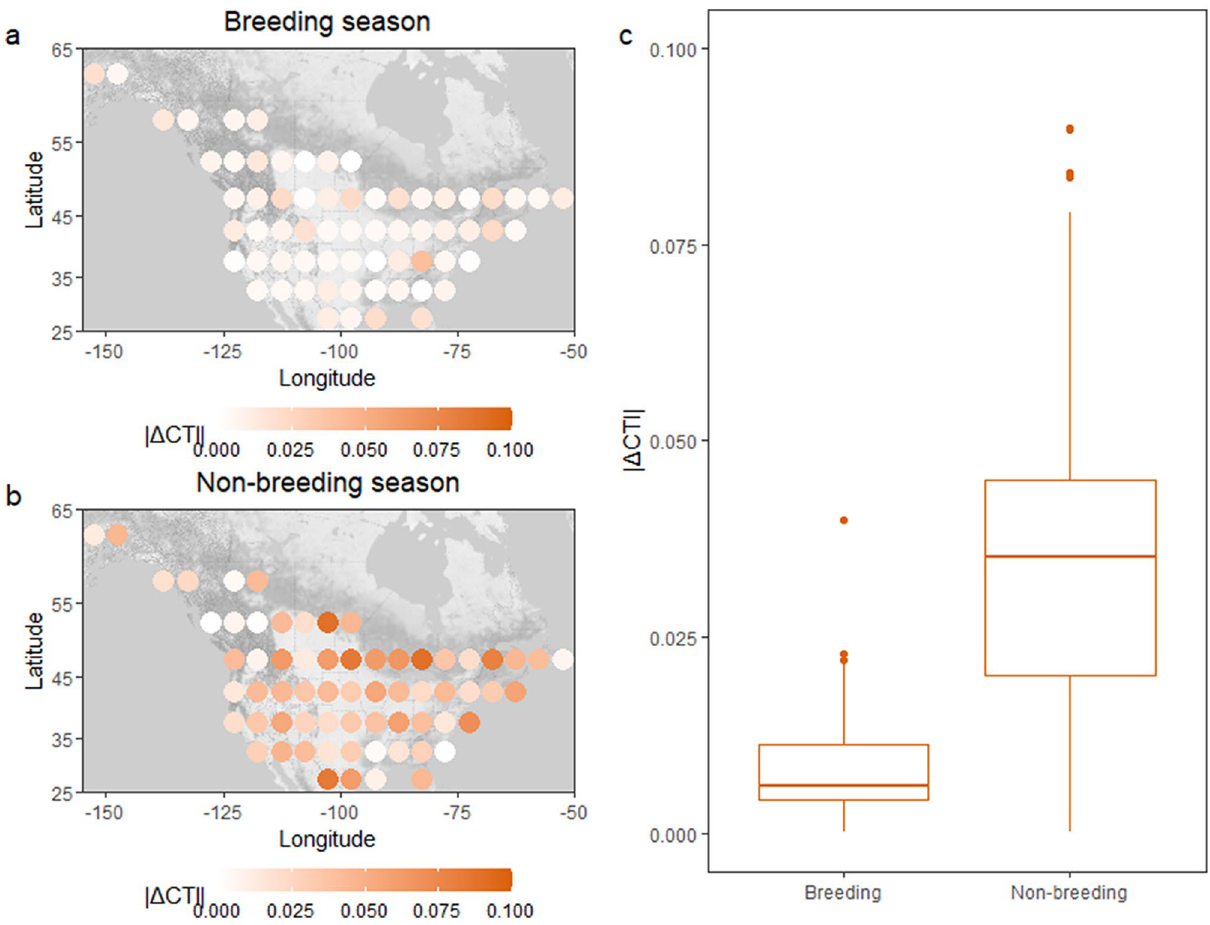
Figure 2. Spatial and seasonal variation in thermal variability. Grid cells of 5° × 5° were considered as study units (N = 65) across North America. Panels ( a ) and ( b ) illustrate the temporal trend in community temperature index (|∆CTI|; thermal variability) in breeding and non-breeding seasons, respectively. Panel ( c ) illustrates the seasonal difference in thermal variability values. In total, 586 and 698 species were included in the breeding and non-breeding season data analyses, respectively (for full species lists, see Appendix S2). The colour gradients show the thermal variability measure variation among grid cells. Figure was produced using R software